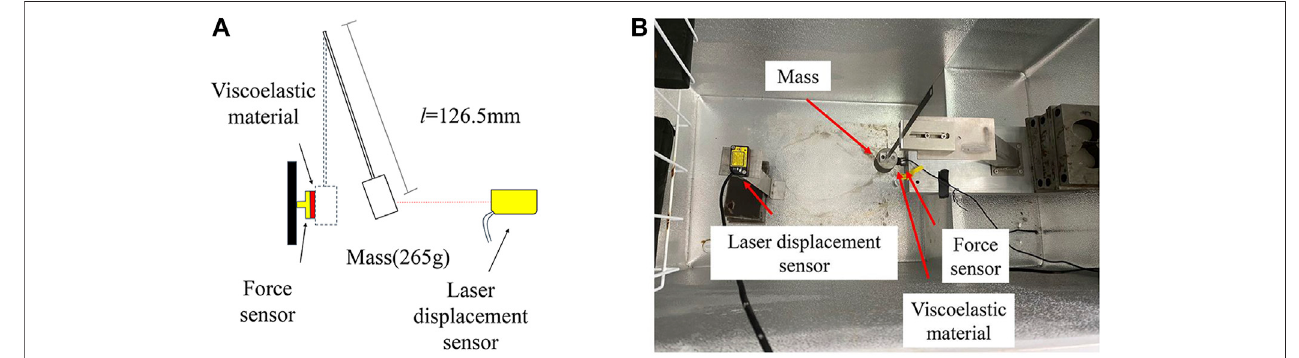
FIGURE 11 | (A) Diagram of impact test setup; (B) Photo of experimental setup.